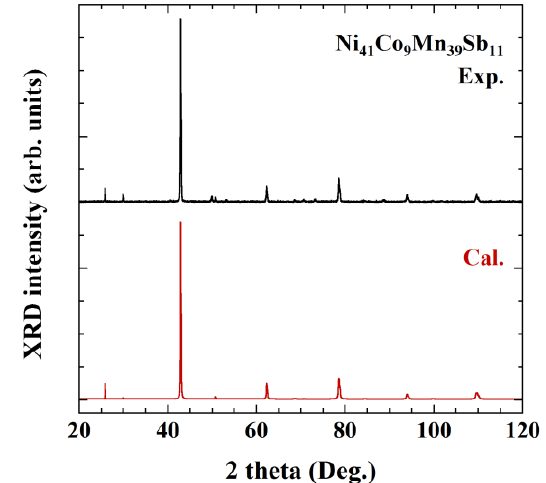
Figure 1. X-ray powder diffraction patterns for Ni 41 Co 9 Mn 39 Sb 11 alloy annealed and quenched from 1173